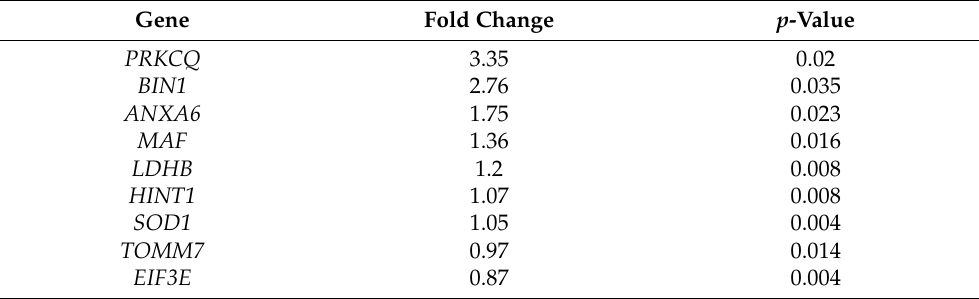
Table 2. Table showing genes with significant changes in gene expression before and after combined exercise and nutrient supplement